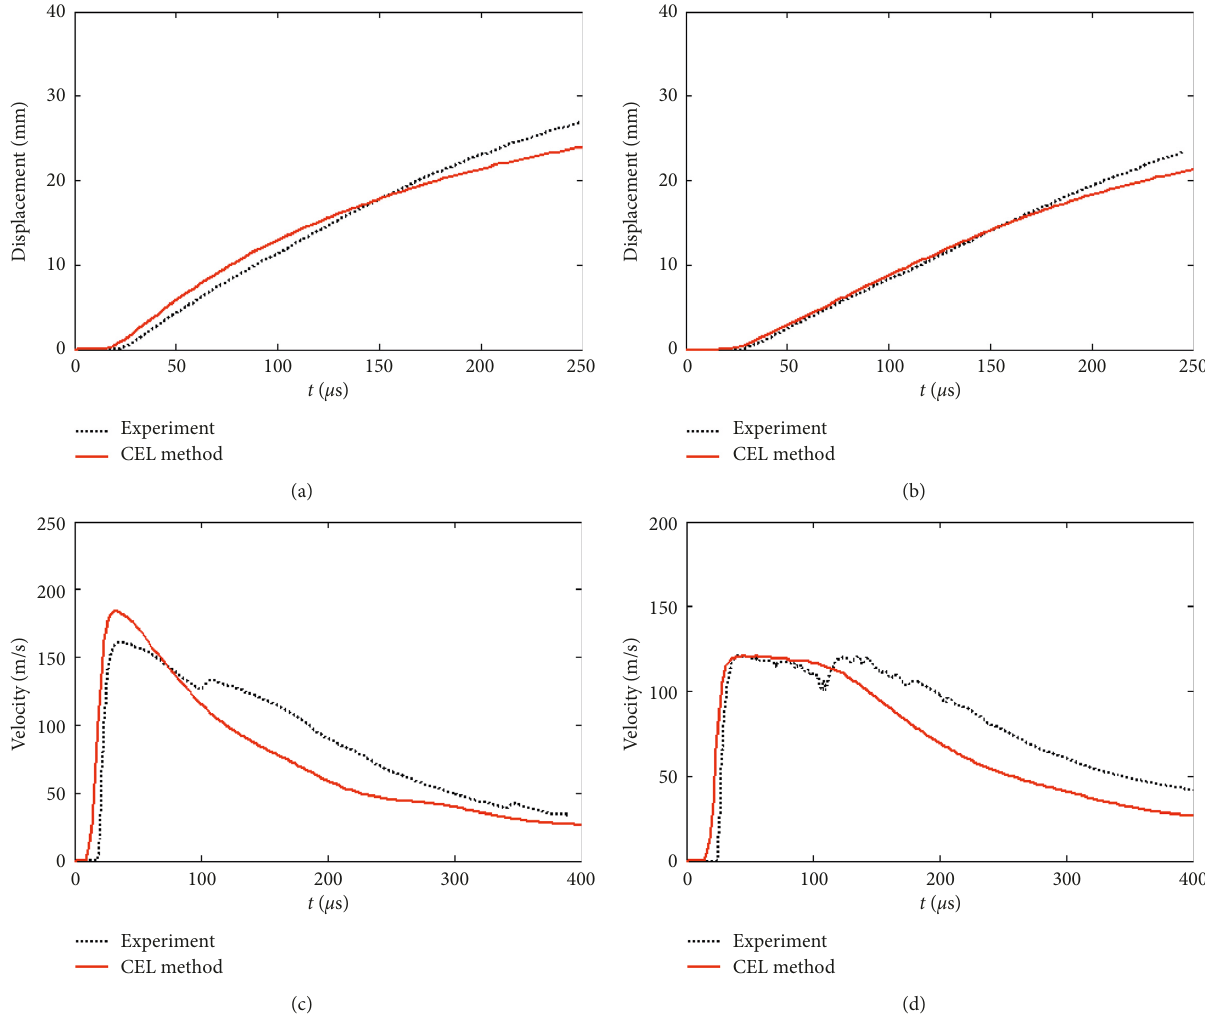
Figure 8: Displacement and velocity time histories at D 1 and D 2 points (these experimental data are provided by the Institute of Fluid Physics, China Academy of Engineering Physics): (a) the displacement at D 1 point; (b) the displacement at D 2 point; (c) the velocity at D 1 point; (d) the velocity at D 2 point.